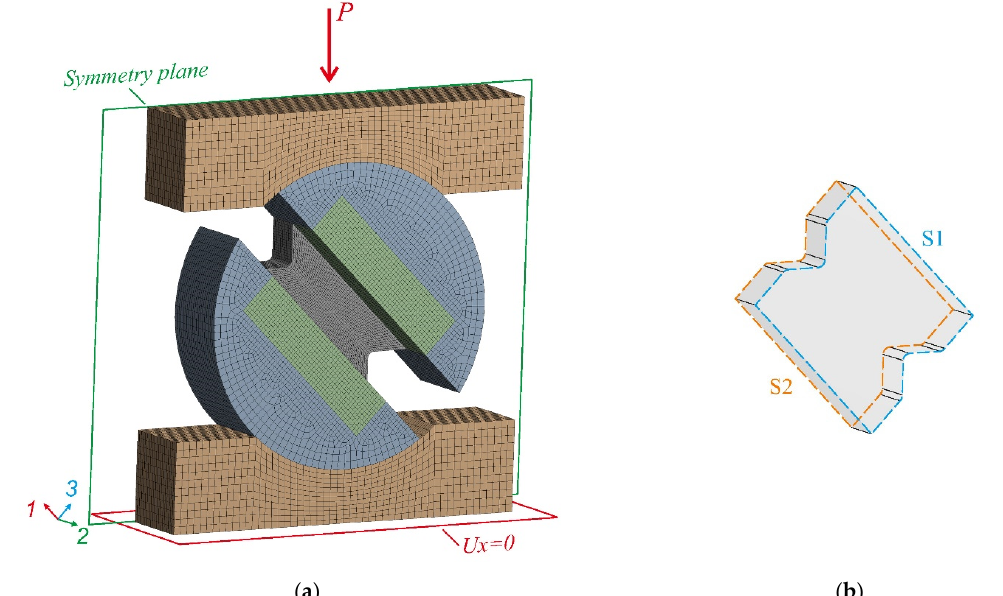
Figure 4. Finite-element mesh, boundary conditions, and loads ( а ); face (S1) and middle (S2) surfaces of the specimen ( b ).